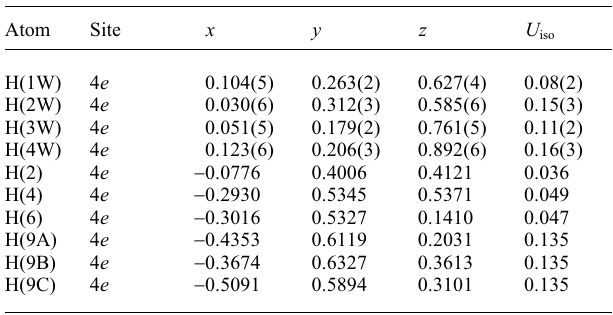
Table 3. Atomic coordinates and displacement parameters (in Å 2 ) .